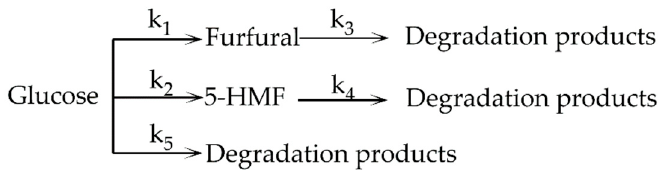
Scheme 2. Simplified reaction scheme for the conversion of glucose.